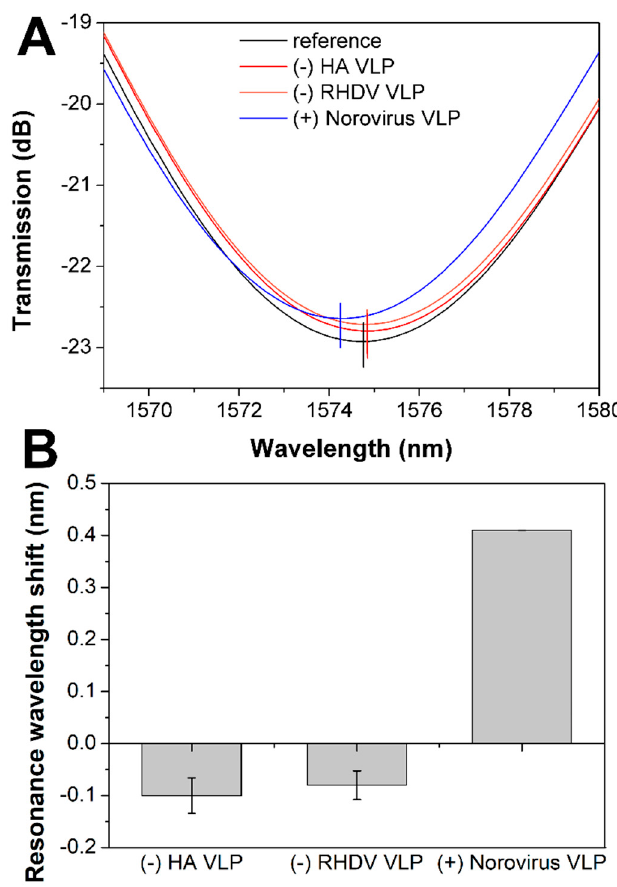
Figure 6. Selectivity analysis of long-period fiber grating (LPFG) biosensor. ( A ) Representative spectra recorded in PBS before specificity test, after incubation in two non-specific VLPs (hemagglutinin protein (HA) VLP and Rabbit hemorrhagic disease virus (RHDV) VLP) and specific norovirus VLPs. ( B ) Resonance wavelength shifts for left resonance for two negative controls (HA VLP and RHDV VLP) and positive control (norovirus VLP).